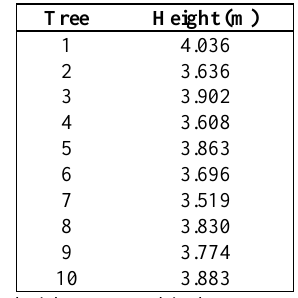
Table 4. Tree height measured in the generated dense point cloud.